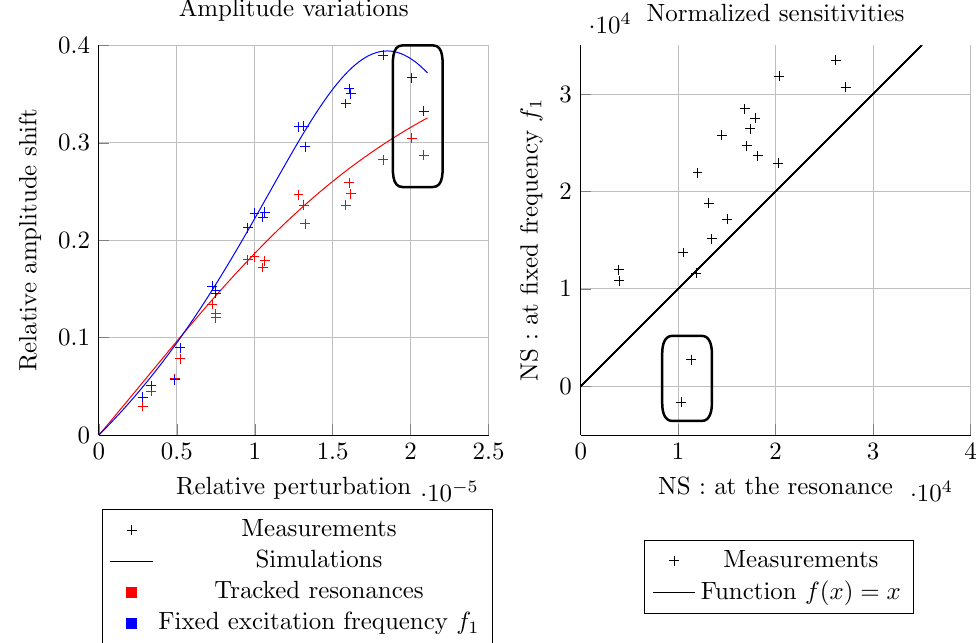
Figure 13. Amplitude variations and their corresponding normalized sensitivities of the first mode of resonator 2 where the particles are deposited for both methods: tracked resonances and fixed excitation frequency f 1